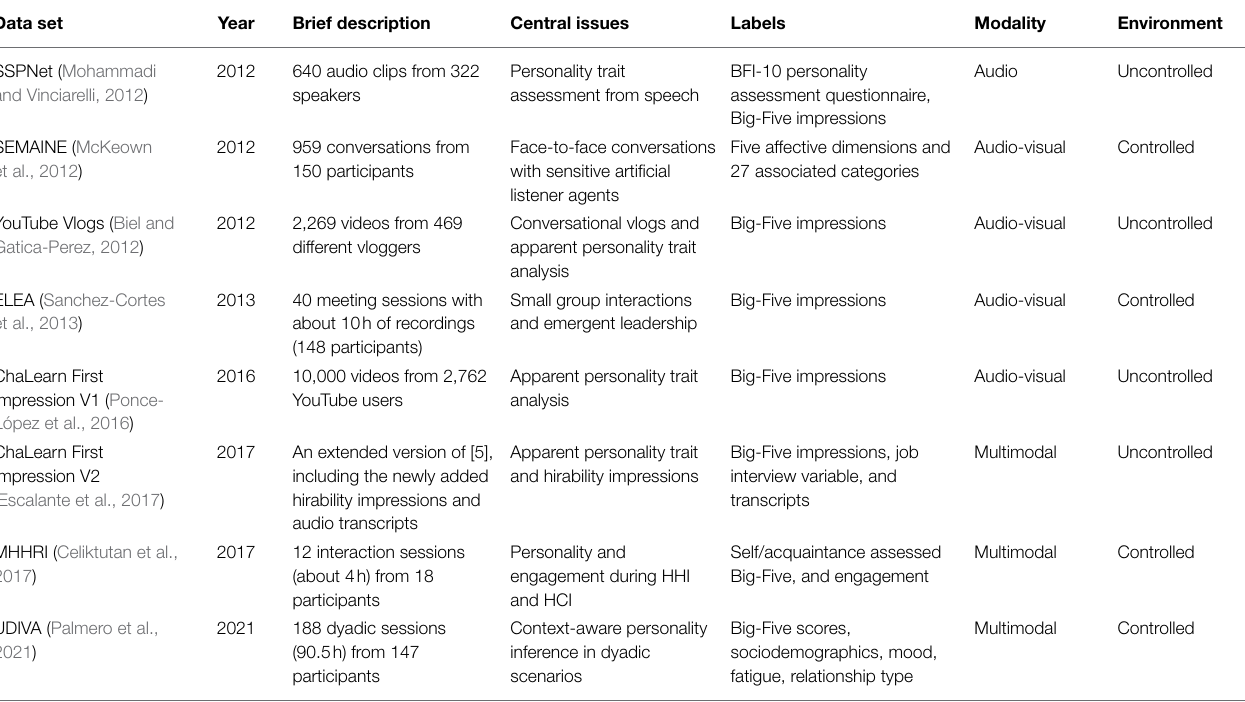
TABLE 1 | Comparisons of representative personality trait recognition